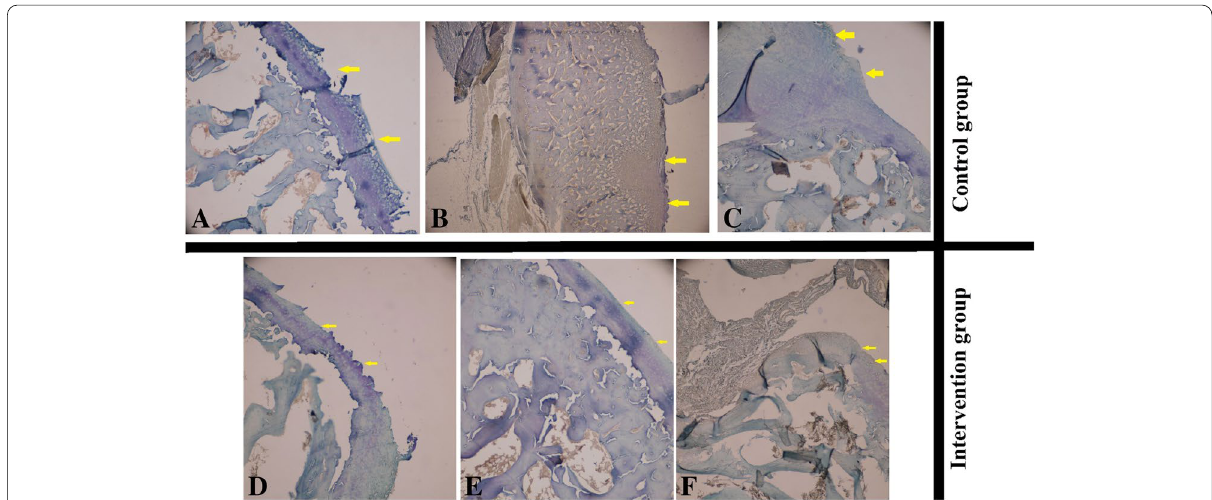
Fig. 3 Control group: A Grade Four; B Grade Five; C Grade Six; Intervention group: D Grade Three; E Grade Four; F Grade Five. Articular surface damage is obvious in both the control and intervention groups; however, the severity of damage is more severe in the control group. After the intervention, the severity of fibrosis is decreased with less articular damage ( 40) (yellow arrow indicator of articular ×